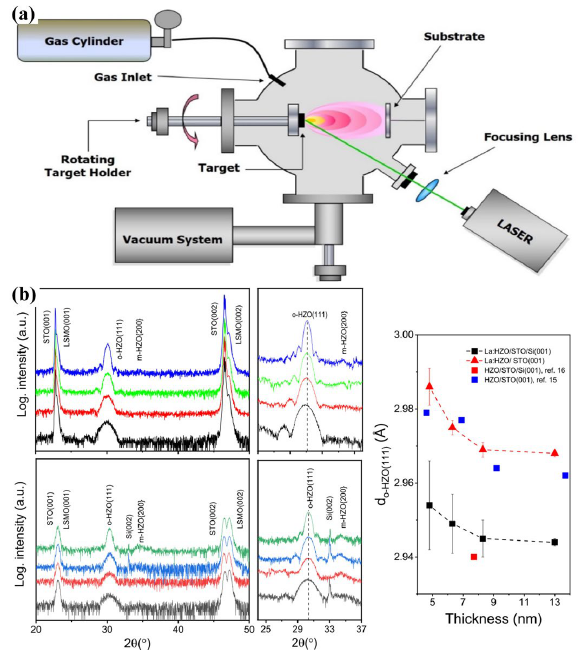
Figure 5. ( a ) The system of pulsed laser deposition. Reprinted with permission from [40] © 2020 MDPI. ( b ) XRD θ –2 θ scans of La: HZO thin films on LSMO/STO (001) and LSMO/STO/Si (001), the out of plane o-HZO (111) lattice distance of La: HZO thin films on LSMO/STO (001) (red triangle) and LSMO/STO/Si (001), plotted as a function of thickness. Reprinted with permission from [46] © 2020 American Chemical Society.